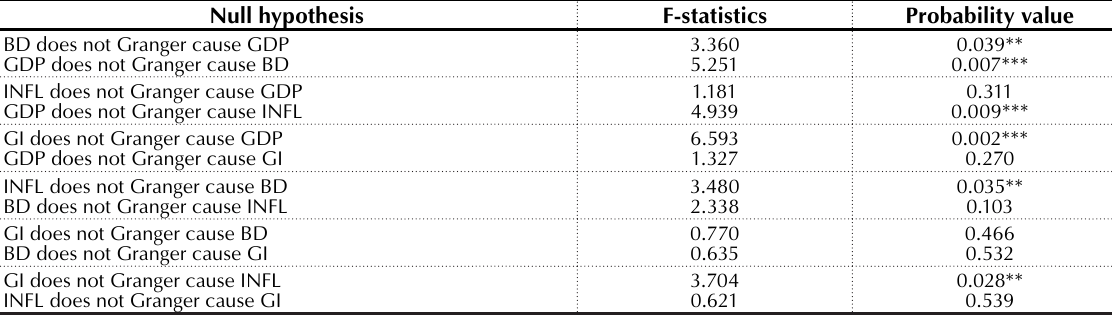
Table 5. Pa nel Granger causality